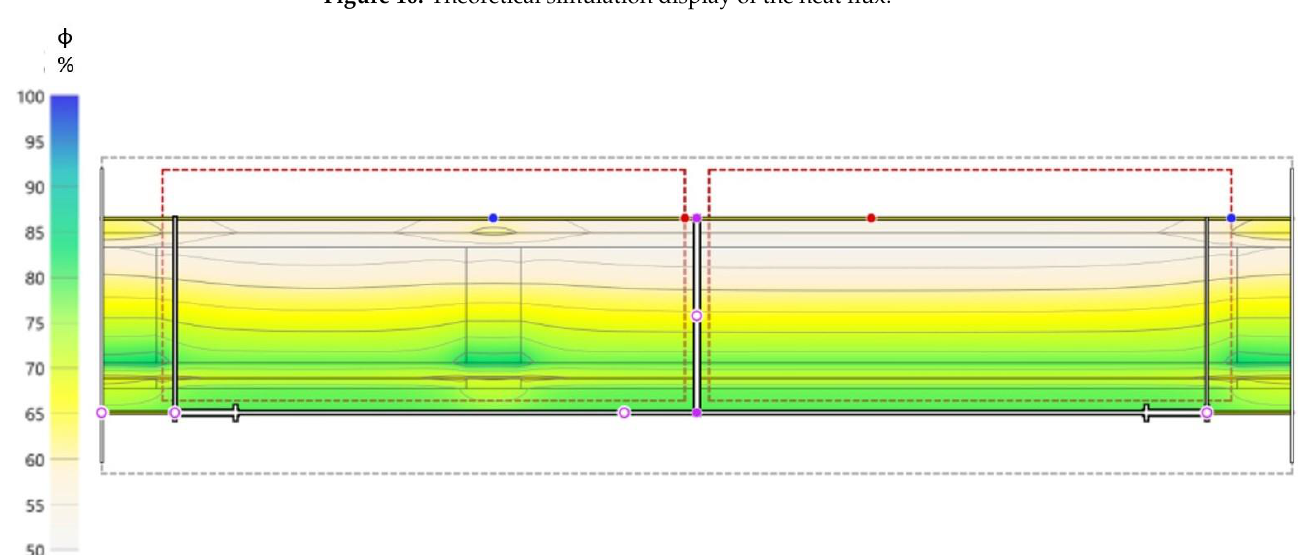
255 257 258 259 260 255